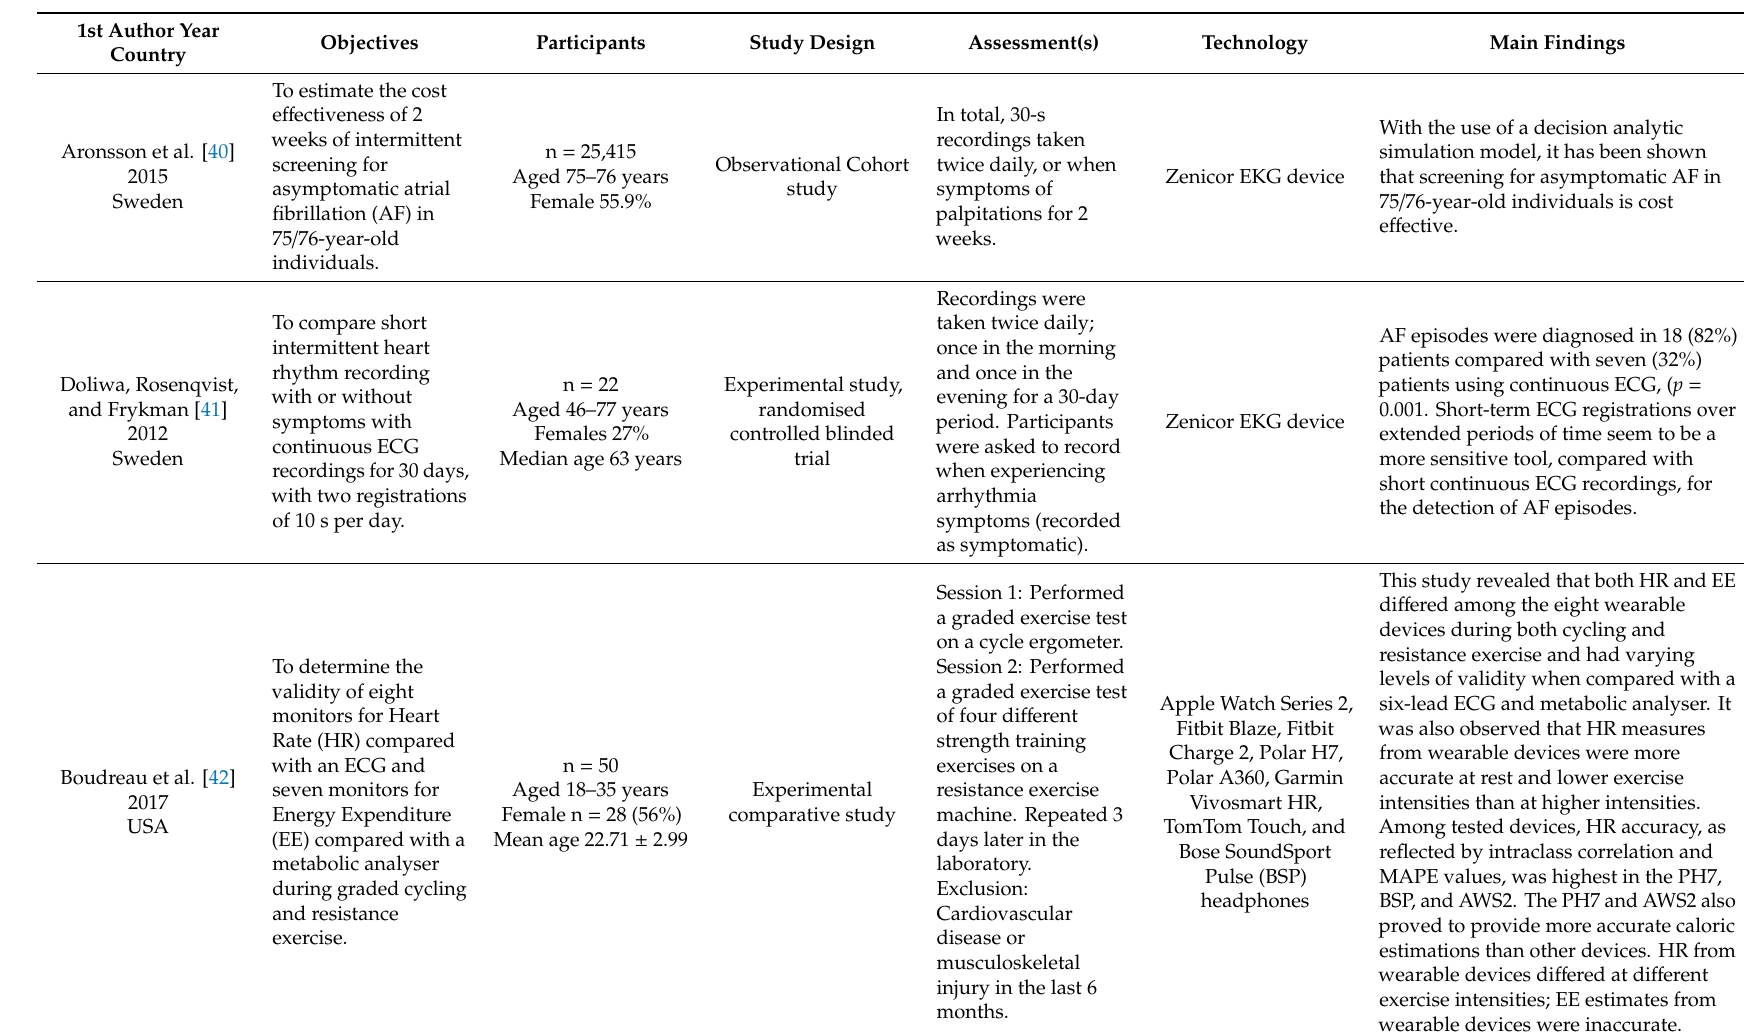
Table 3. Summary of articles (N = 9) included for this scoping